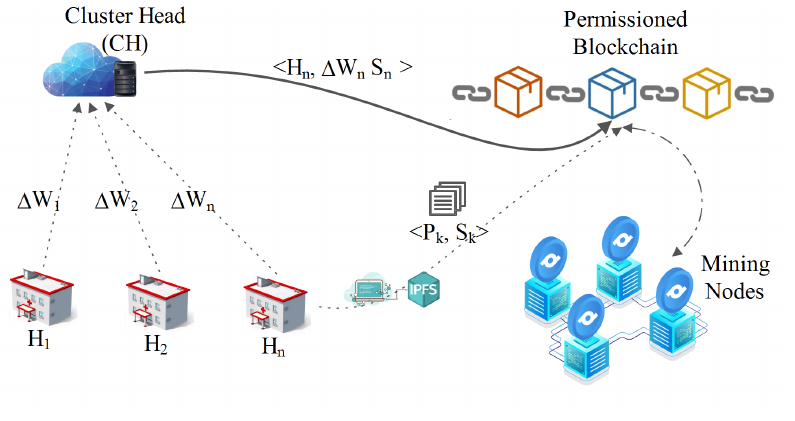
Figure 6. Block-Chain for